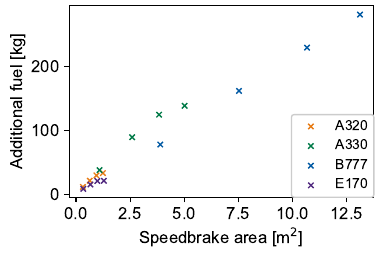
Figure 9. Comparison of four Aircraft types regarding the increase in additional fuel consumption depending on effective speed brake area. For initial conditions, see Figure